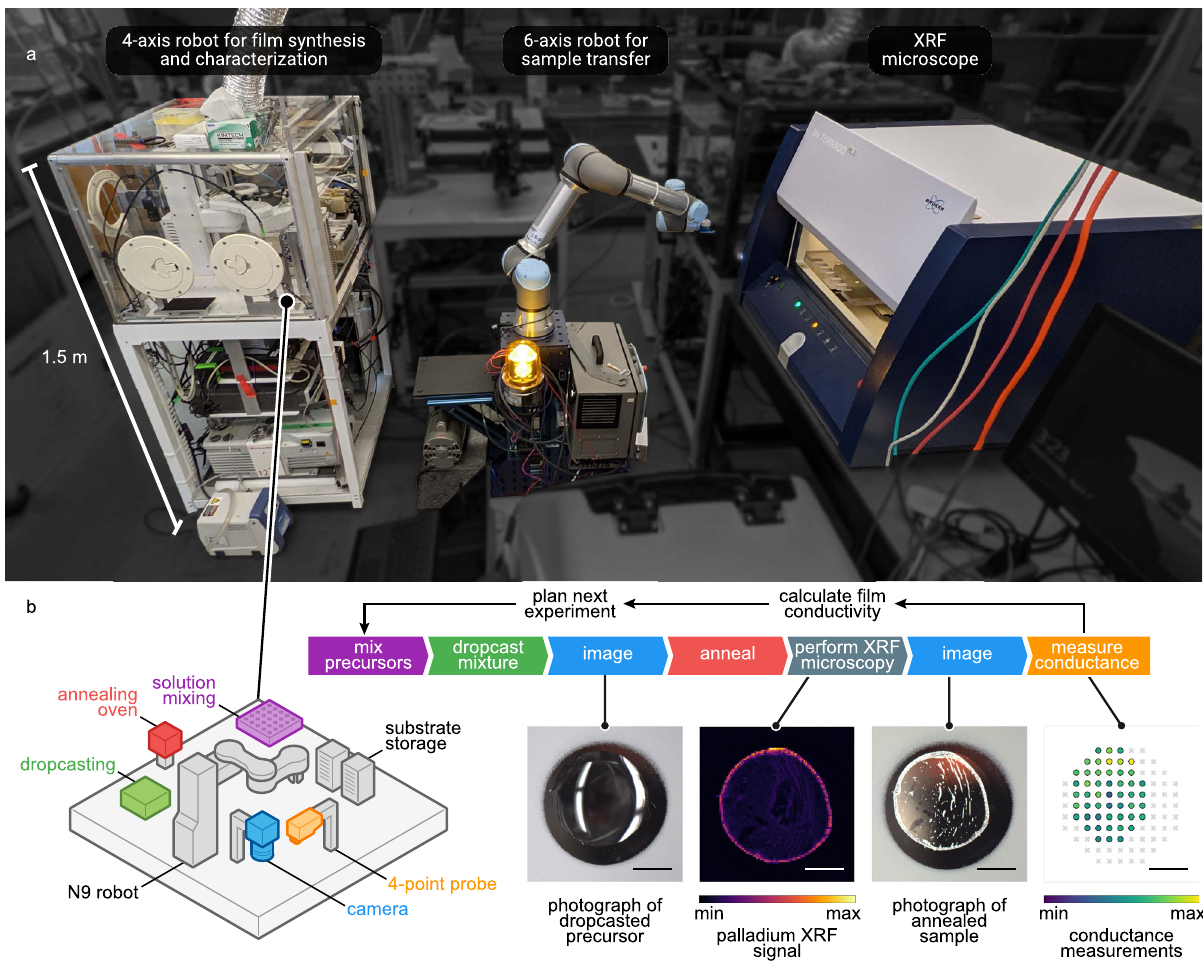
Fig. 2 The Ada self-driving laboratory and autonomous experimental work fl ow. a Schematic of the Ada self-driving laboratory. Ada consists of two robots (N9 and UR5e) with overlapping work envelopes. These robots work together to synthesize and characterize thin fi lm samples. The N9 robot is a 4-axis arm equipped to mix, drop cast, and anneal precursors to create thin- fi lm samples. The N9 also performs imaging and 4-point probe conductance measurements on the fi lms it creates. The UR5 robot is a larger 6-axis arm equipped to transport samples to additional modules, including an XRF microscope. b Steps in the automated experimental work fl ow. Each iteration of the experiment produces a single, drop-cast, thin- fi lm sample; images of the sample before and after annealing; an XRF map of the quantity of palladium in the fi lm; and a map of the fi lm conductance measured by the 4-point-probe at different locations on the sample. After the sample is characterized, the fi lm conductivity is calculated and the qEHVI algorithm is used to autonomously plan the next experiment. All scale bars are 5